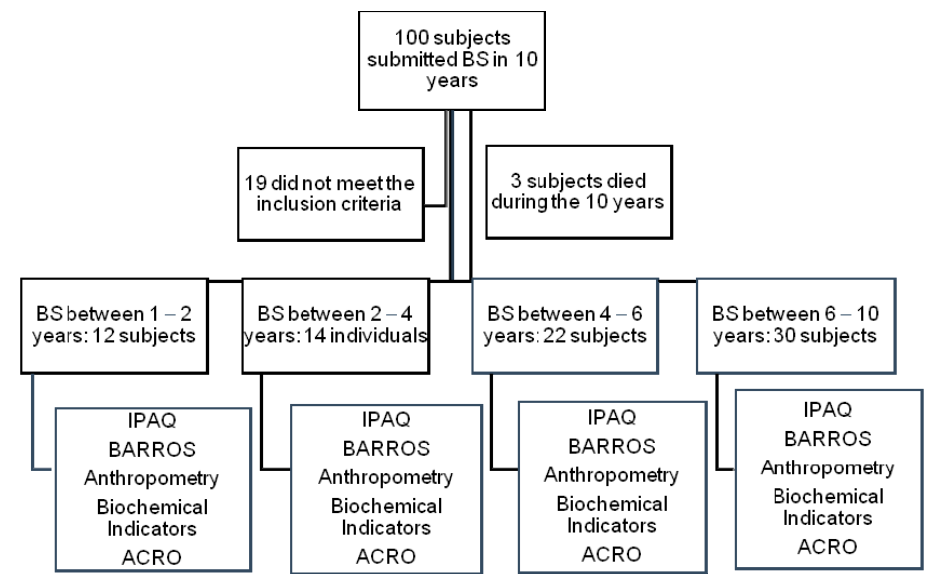
Figure 1. Study design. BS: Bariatric Surgery, IPAQ: International Physical Activity Questionnaire, BAROS: Bariatric Analysis and Reporting Outcome System Questionnaire, Anthropometry: weight (kg), height (cm), waist circumference (cm) (HDL, LDL), triglycerides, fasting glycemia (at four time points: admission, release, postoperative, and final), ACRO: Evaluation of Comorbidities Associated with Obesity.